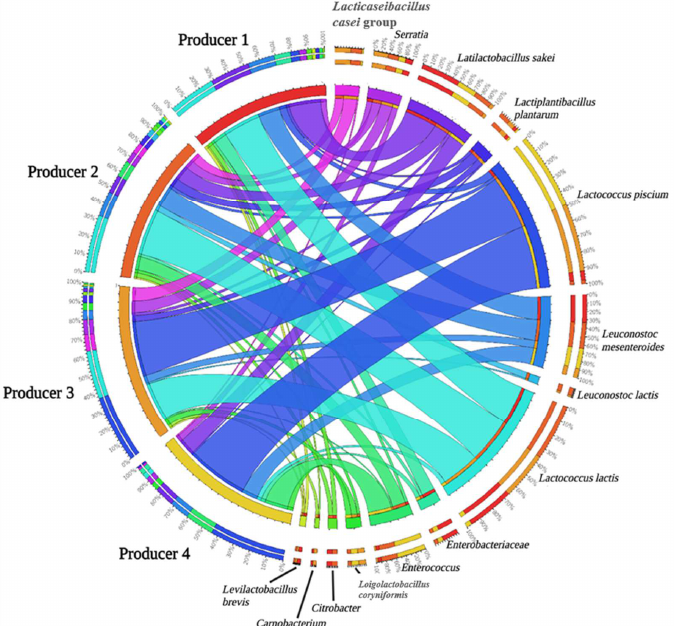
Figure 1. Circular ideogram showing the bacterial distribution (>1% of the relative frequency in at least 2 samples) among the Queijo Serra da Estrela PDO cheese samples herein analyzed. Amplicon Sequence Variants (ASVs) and samples are connected with ribbons, whose thickness is proportional to the abundance of ASVs in the connected samples. The outer circle displays the proportion of each ASV in each producer and vice versa.